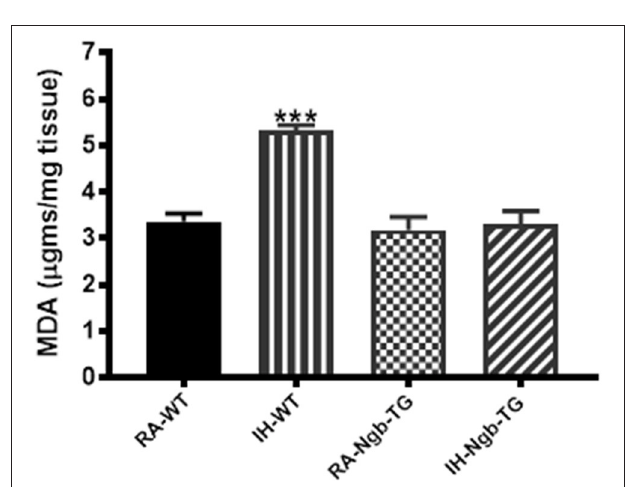
FIGURE 6 | Lipid peroxidation was reduced in the cortex of Ngb-TG mice exposed to IH. MDA tissue levels in cortex of Ngb-TG and WT mice exposed to either room air (RA) or intermittent hypoxia for 14 days (IH). ( n = 6 per experimental group; *** P < 0.0001 vs. RA-WT).